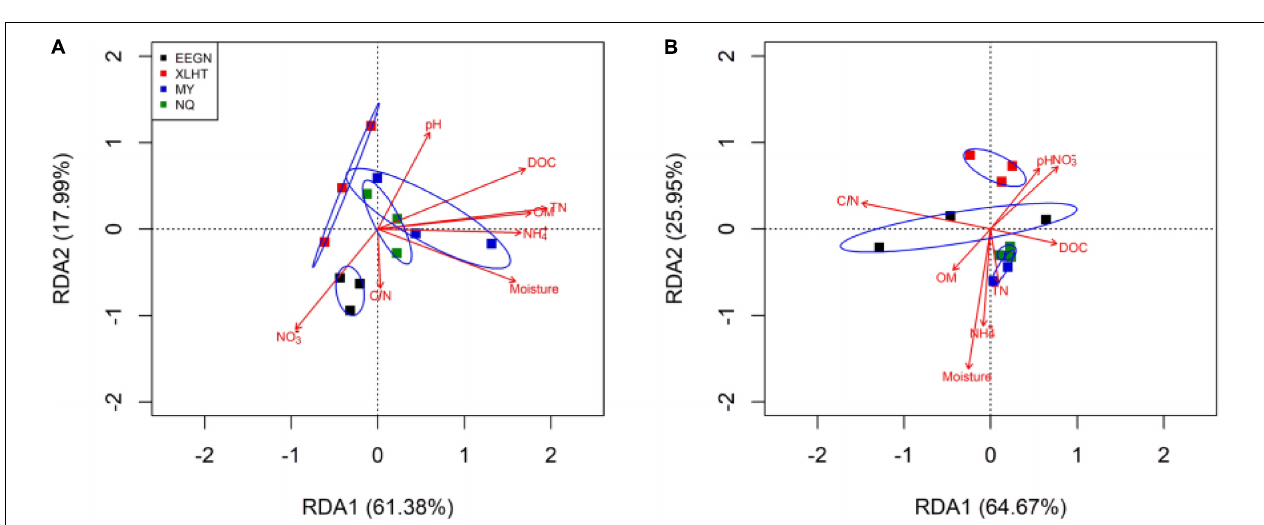
FIGURE 3 | Microbial N storage potential (A) and nitrate leaching potential (B) at soil depths of 0–10 and 30–40 cm at four grassland sites. Values (means ± SD, n = 3) within the same soil depth followed by different letters are significantly different at P < 0.05 according to LSD post hoc test. An asterisk above the bars indicates a significantly different level at P < 0.05 according to the student t -test for a given sampling site. * P < 0.05; ** P < 0.01. The site abbreviations are defined in Table 1 .